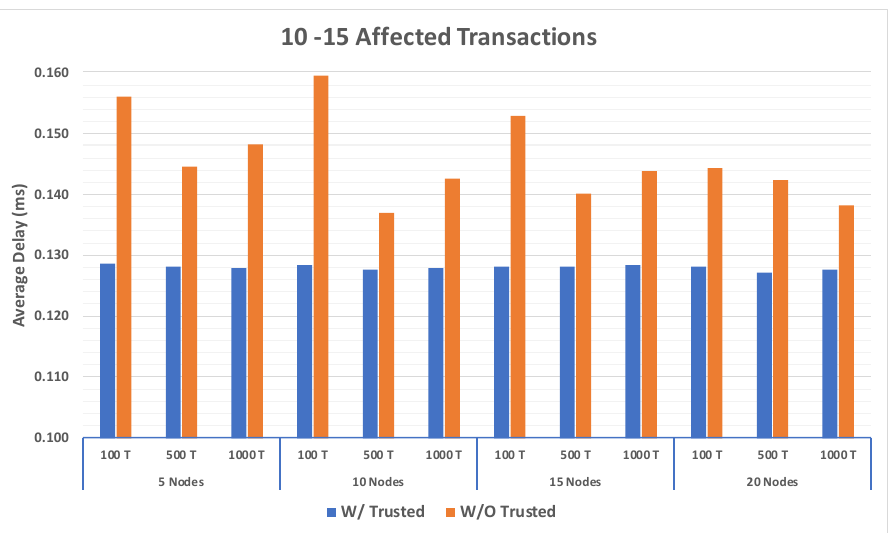
Figure 11. Comparison between having global graph on trusted fog node and not on set of 10 to 15 affected